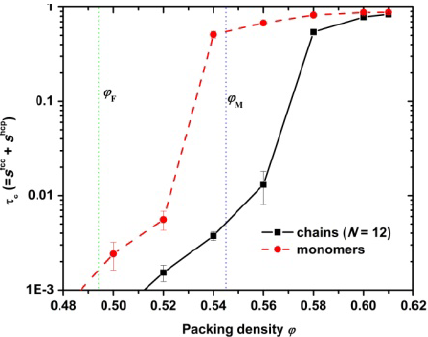
) and melting points ( φ ), F M